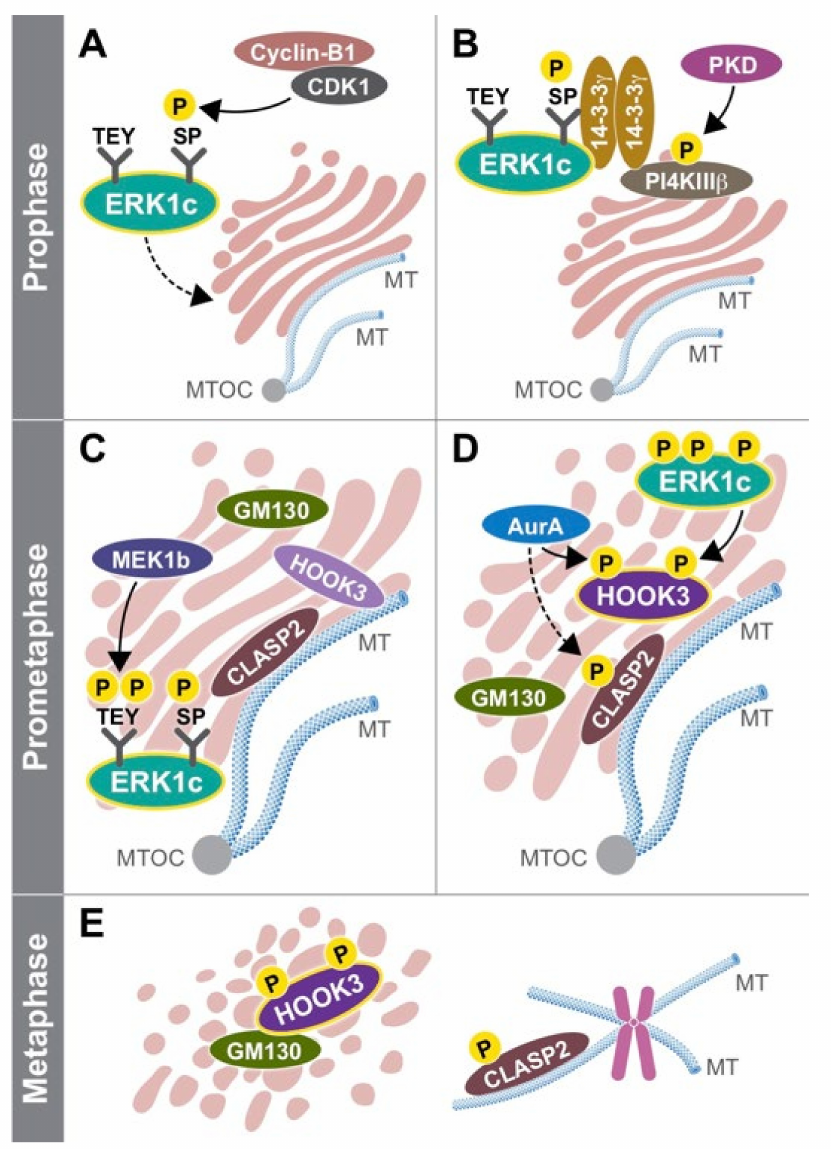
Figure 2. Schematic presentation of ERK1c function in the Golgi. An illustration demonstrating the unique role of ERK1c isoform in the Golgi fragmentation process at different stages of the cell cycle. Prophase : ( A ) CDK1 becomes active, and phosphorylates ERK1c on Ser343 in its unique C -terminus. ( B ) Phosphorylated ERK1c interacts with a shuttling complex of PI4KIII β and 14-3-3 γ , which mediates its Golgi translocation. Prometaphase: ( C ) In the Golgi, ERK1c is phosphorylated by MEK1b, becomes fully active and induces mitotic Golgi fragmentation. The Golgi is organized in stacks, while GM130 is found in between these stacks. The microtubules (MTs) are polymerized from the microtubules originating center (MTOC) and stabilize the Golgi structure. Both HOOK3 and CLASP2 interact together with the MTs and Golgi. ( D ) Once entering mitosis, HOOK3 is phosphorylated by both ERK1c and AurA, while CLASP2 might be phosphorylated by AurA. At this time the Golgi stacks starts to break into ribbons. Metaphase : ( E ) The phosphorylation of HOOK3 and CLASP2 allow the complete fragmentation of the Golgi into a haze. At this time, phosphorylated CLASP2 maintains its interaction with the MTs that originate from the centromeres, while phosphorylated HOOK3 interacts with